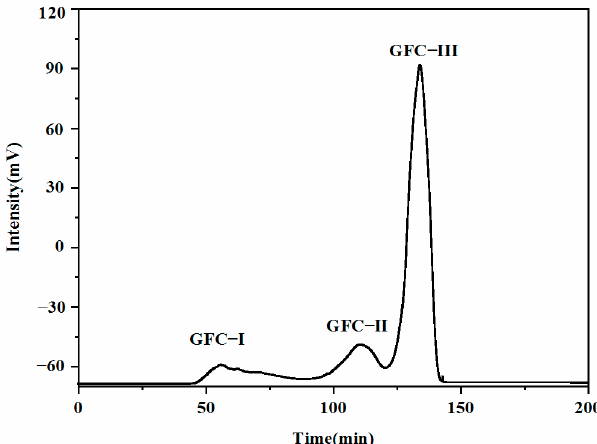
Figure 5. Gel filtration chromatography of the mixture of fractions GFC-I, GFC-II, and GFC-III.